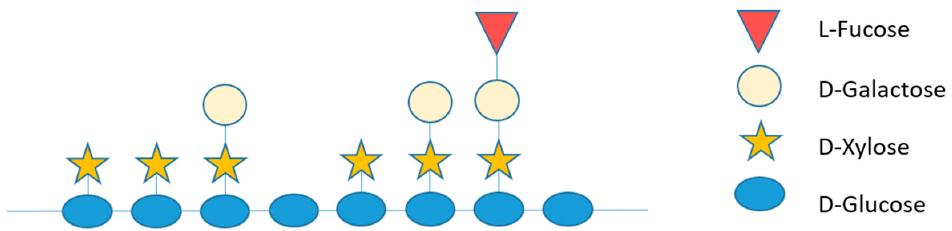
Figure 1. Schematic representation of the hemicellulosic polysaccharide xyloglucan.